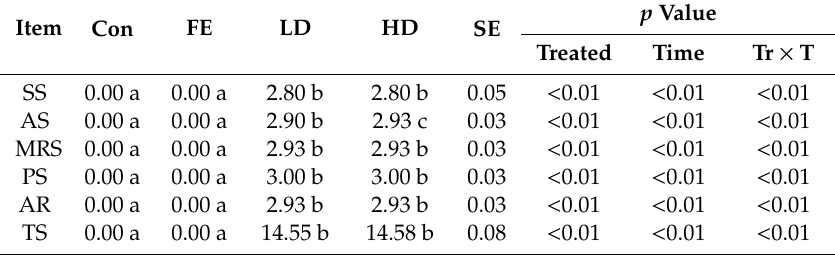
Table 2. Scores of the reflective e ff ects of emulsified isoflurane administrated by intravenous infusion in SD rats.